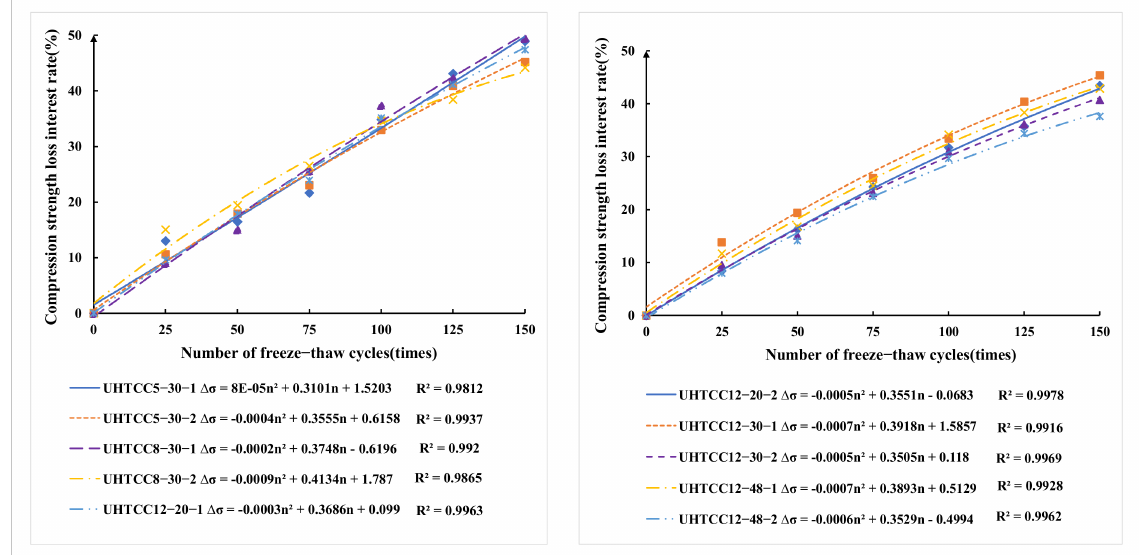
Figure 4. Compressive strength damage under different number of freeze-thaw